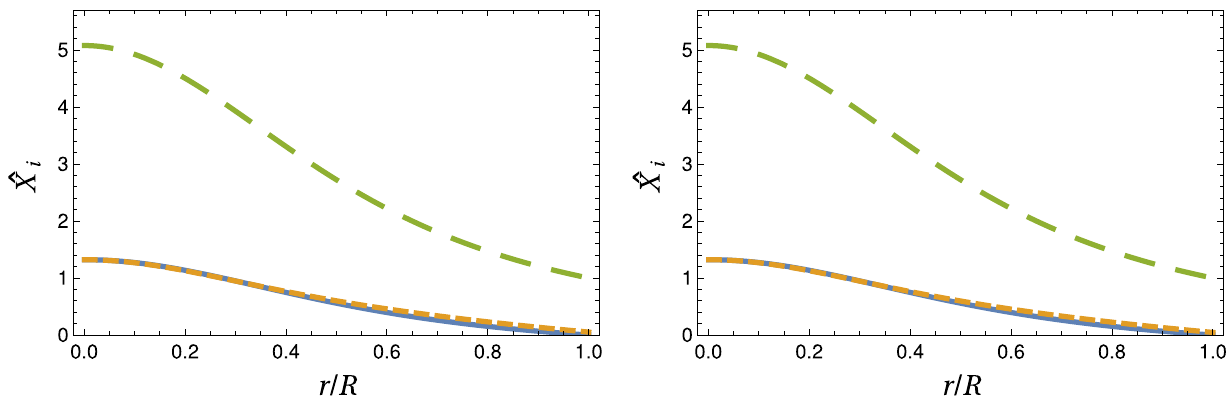
Fig. 2 Dimensionless energy density and pressures (both radial and tangential) X i ≡ (ρ, p r , p t )/ρ s vs dimensionless radial coordinate r / R for the 5th solution obtained here. Left: Solution for the case G (cid:5) ( r = 0 ) = − 0 . 0002 / km (5th solution in Table 1). Right: Solu- tion for the case G (cid:5) ( r = 0 ) = + 0 . 0002 / km (5th solution in Table 2). Shown are: (i) dimensionless radial pressure p r /ρ s (solid blue line), (ii) dimensionless transverse pressure p t /ρ s (short dashed orange line),